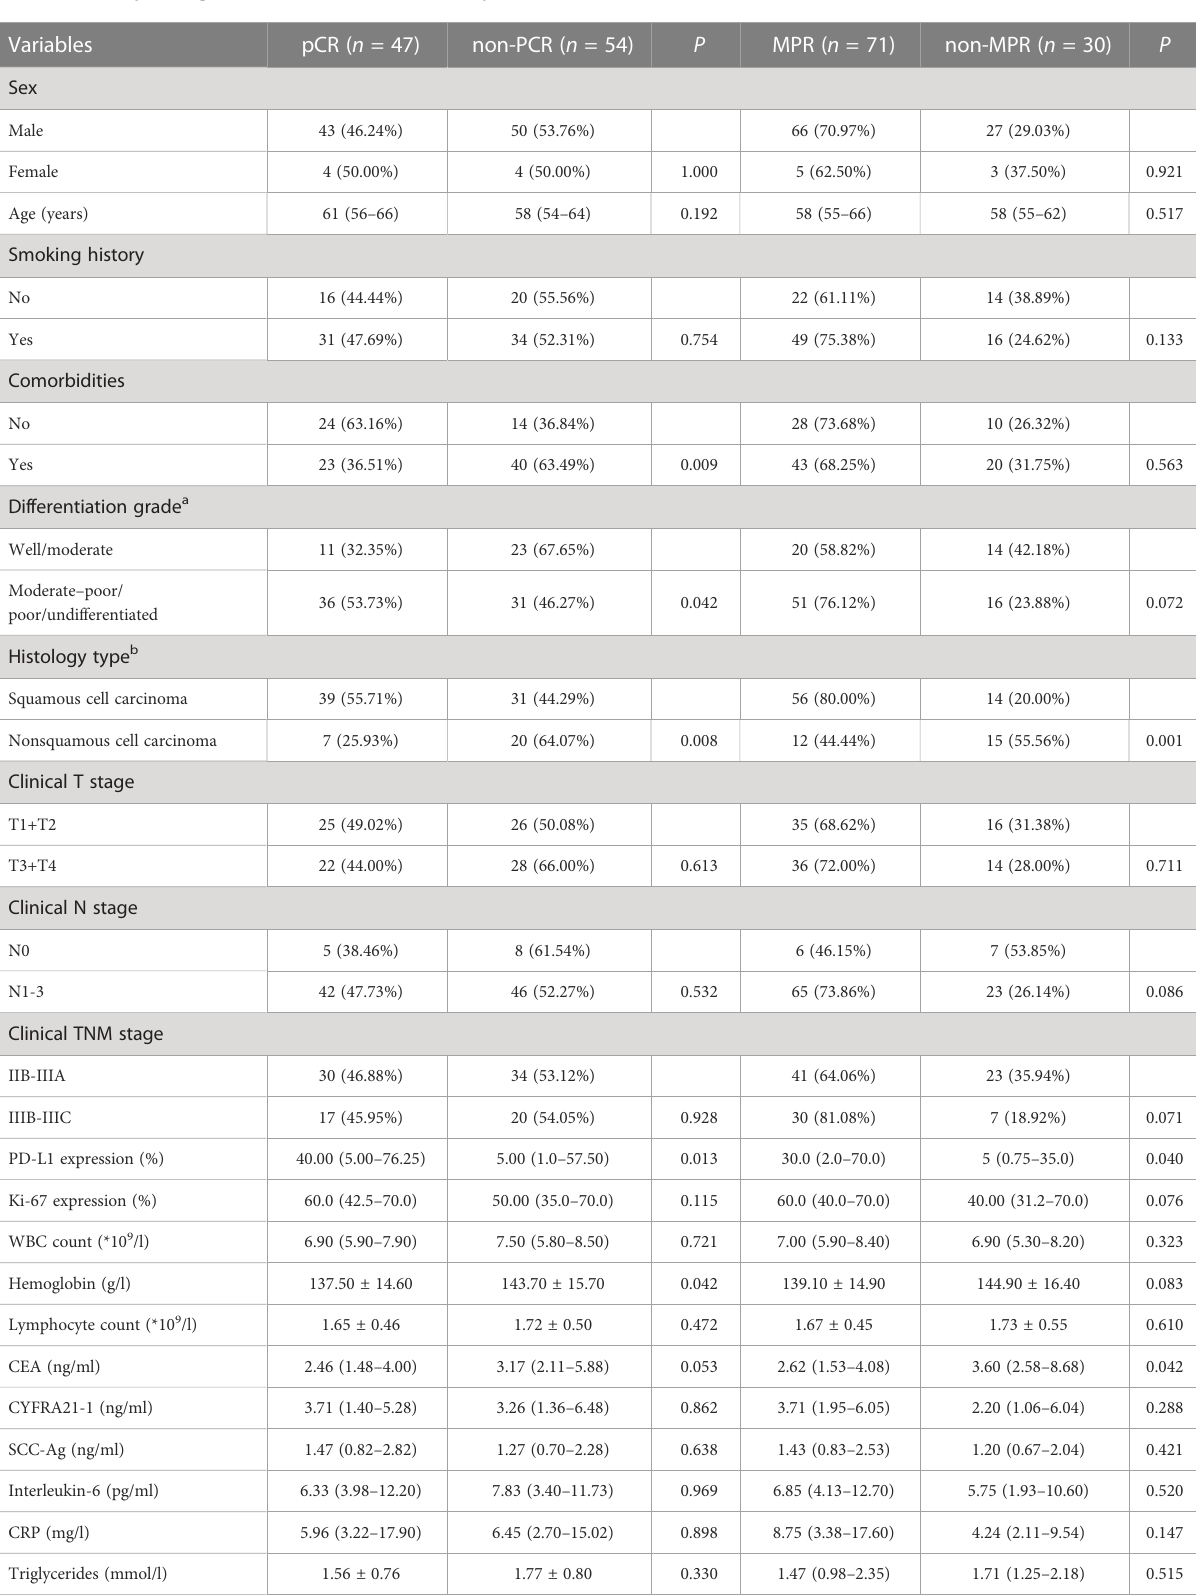
TABLE 3 Clinicopathological factors were associated with pCR or